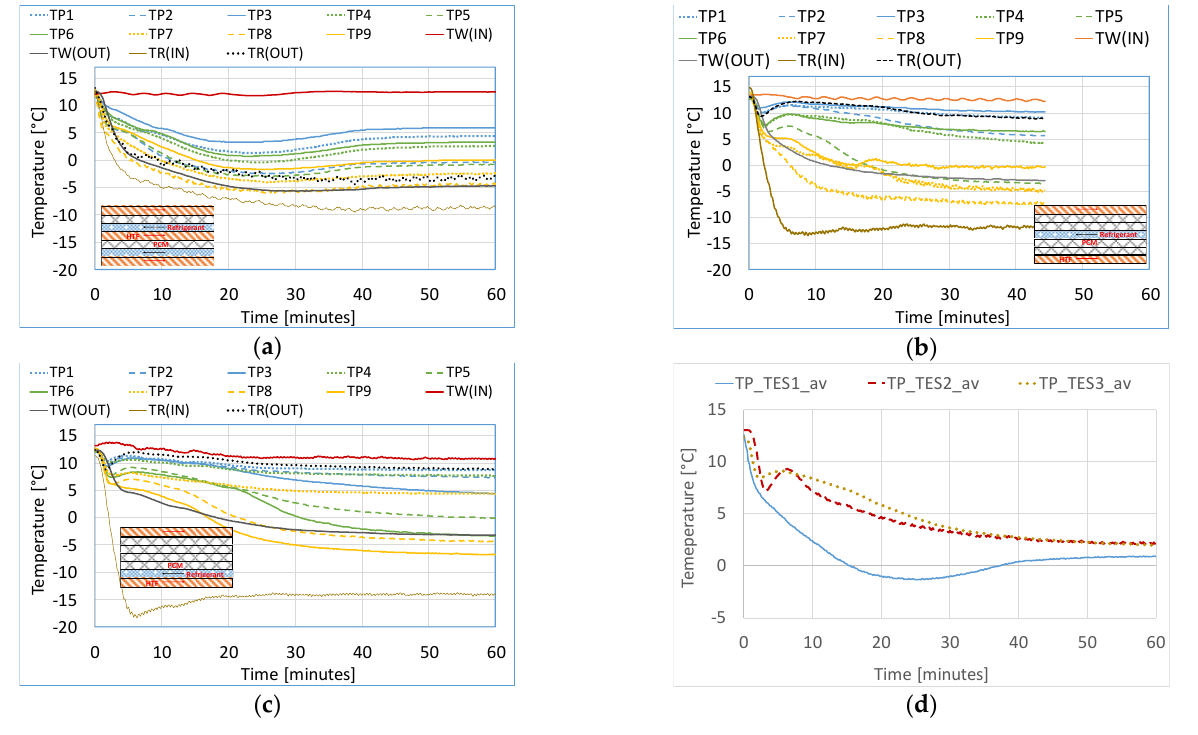
Figure 8. Temperature profiles of three-fluids HEX mode for ( a ) TES 1 , ( b ) TES 2 , ( c ) TES 3 , and ( d ) average temperature in the PCM.